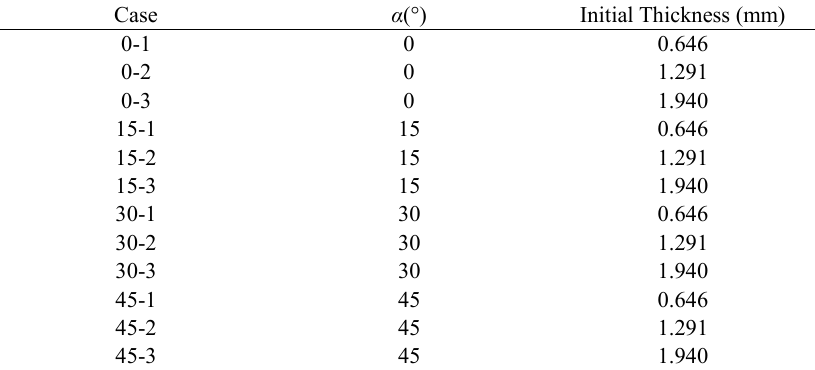
Table 1. Experimental parameters.